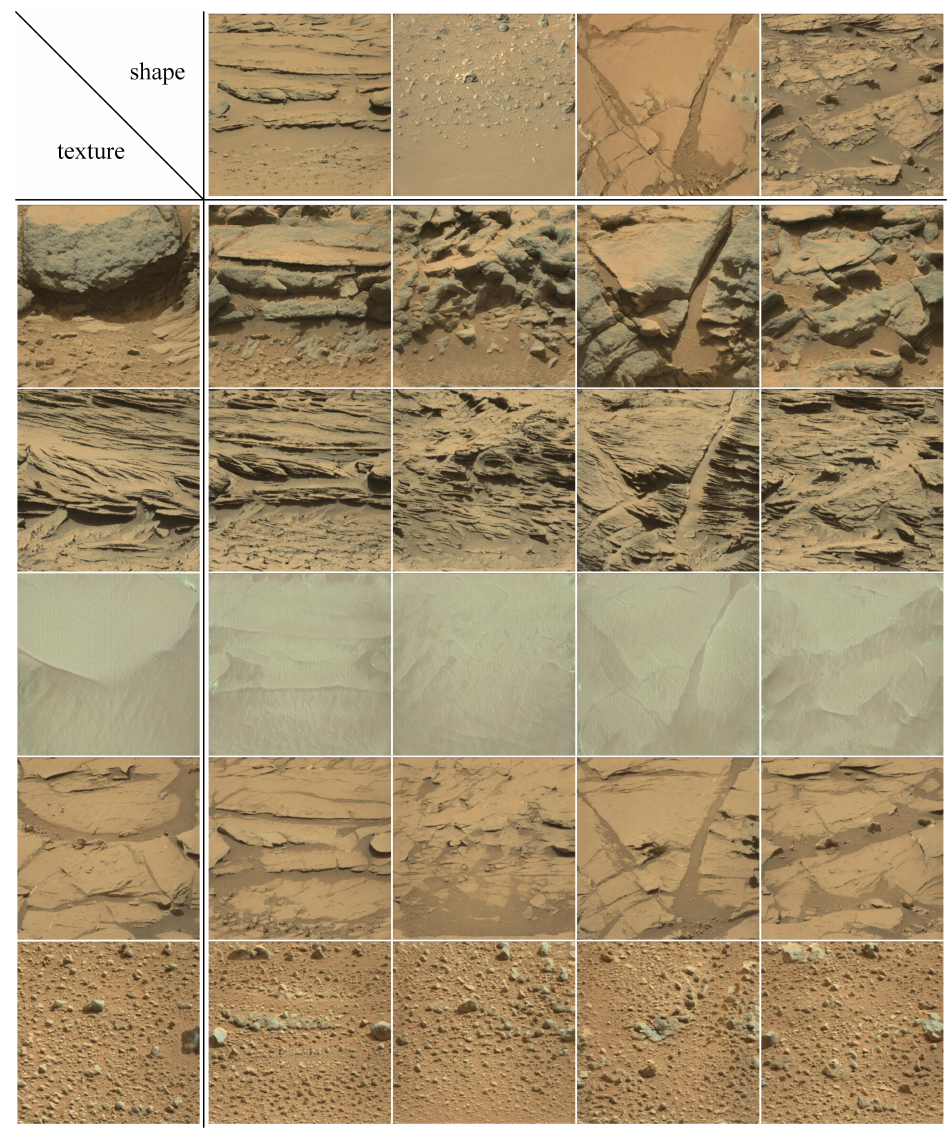
Figure 9. Examples of Martian rock images synthesised by style mixing. The mixed results of five rock textures and four spatial structures are exhibited. It can be seen that after style mixing, the texture of various kinds of rock images in the “texture” list has not changed, but their shape and spatial structure become similar to rock images in the “shape”